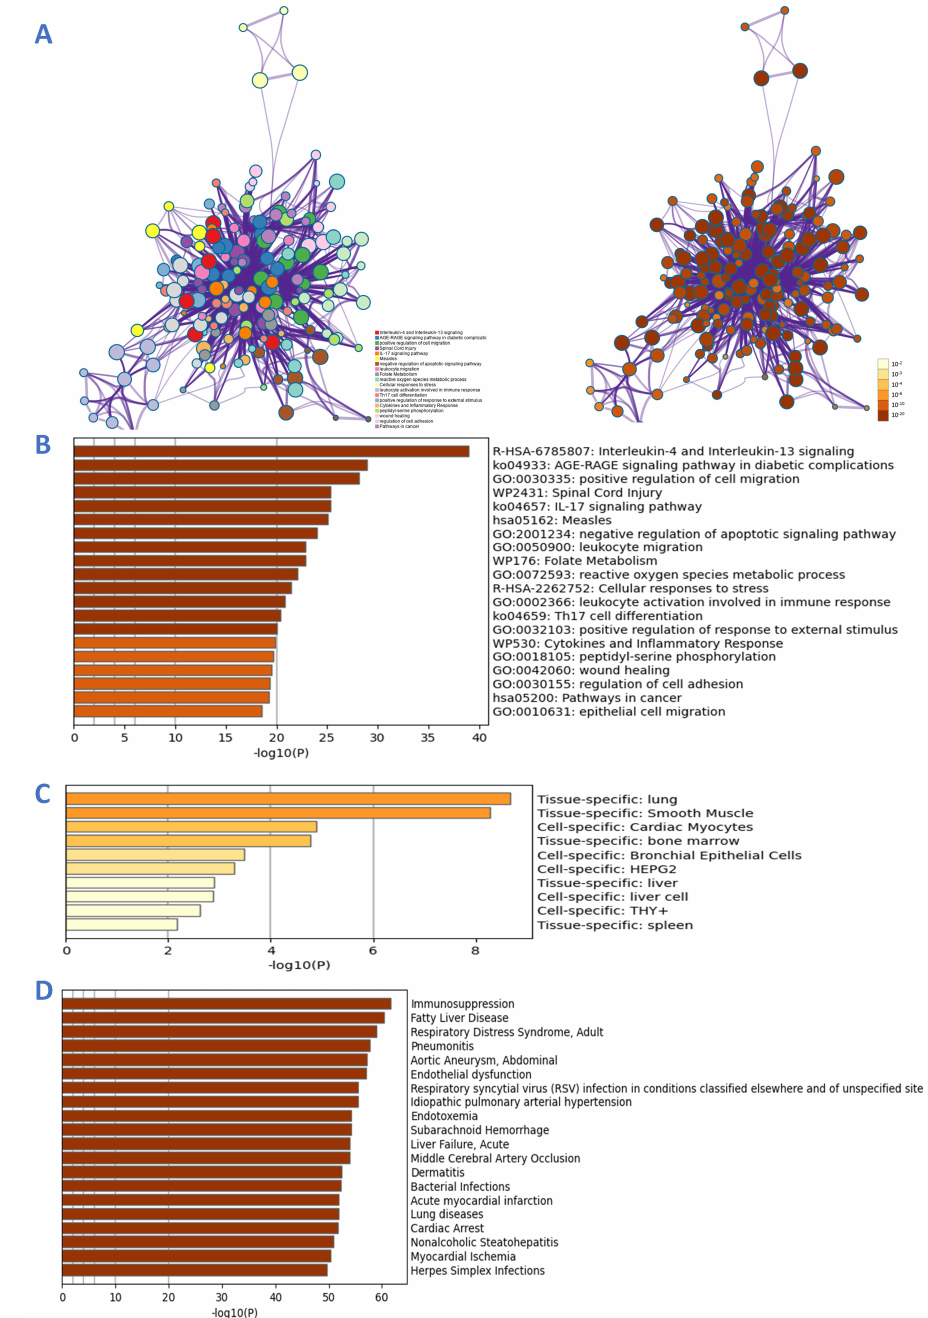
Figure 4. GO analyses of the 67 common targets associated with pneumonia. ( A ) Network of enriched terms: the left-hand side is colored by cluster ID with the best p -values from each of 20 clusters wherein nodes that share the same cluster-ID are typically close to each other; the right-hand side network was colored by p -value, indicating that terms containing more genes tend to have a more significant p -value; ( B ) bar graph of enriched terms colored by p -values to visualize the top 20 clusters; ( C ) summary of enrichment analysis in PaGenBase to demonstrate disease targets–organs location; ( D ) summary of enrichment analysis in DisGeNET to show the relevant